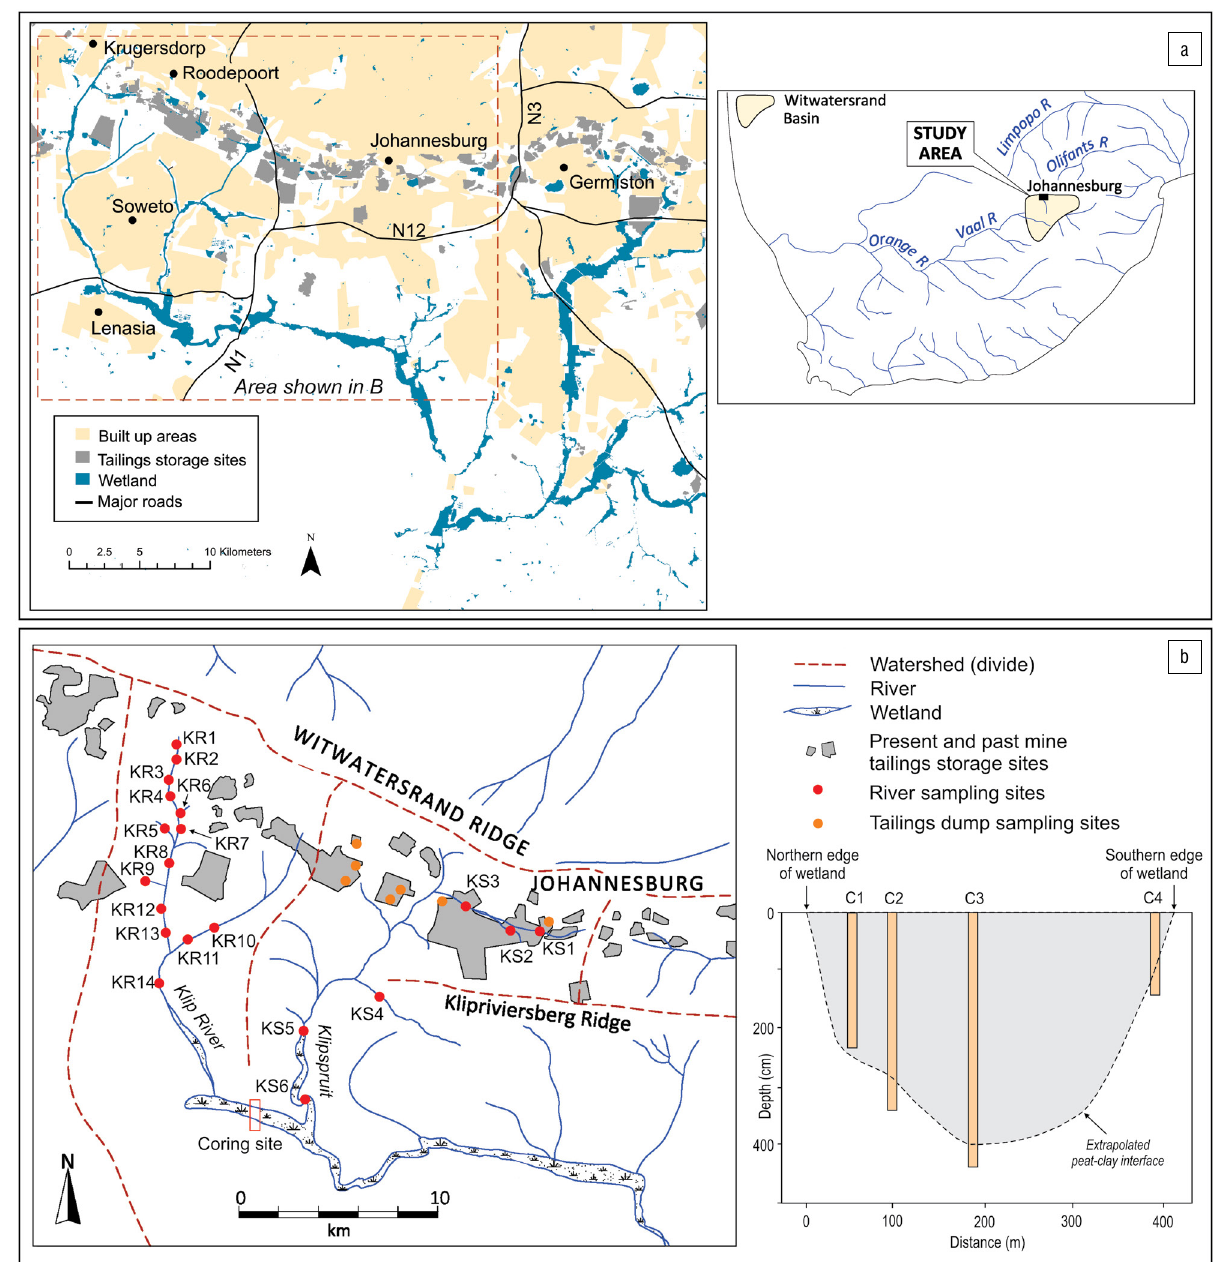
(a) Map of the study area showing the drainage network of the upper Klip River catchment in relation to mining activities and major urban centres in the Johannesburg area. The locations of water and sediment sampling sites along the Klip River (KR1–14) and Klipspruit (KS1–6) are also indicated. (b) Cross-sectional transect across the Klip River wetland showing the position of the four cores (C1–4)